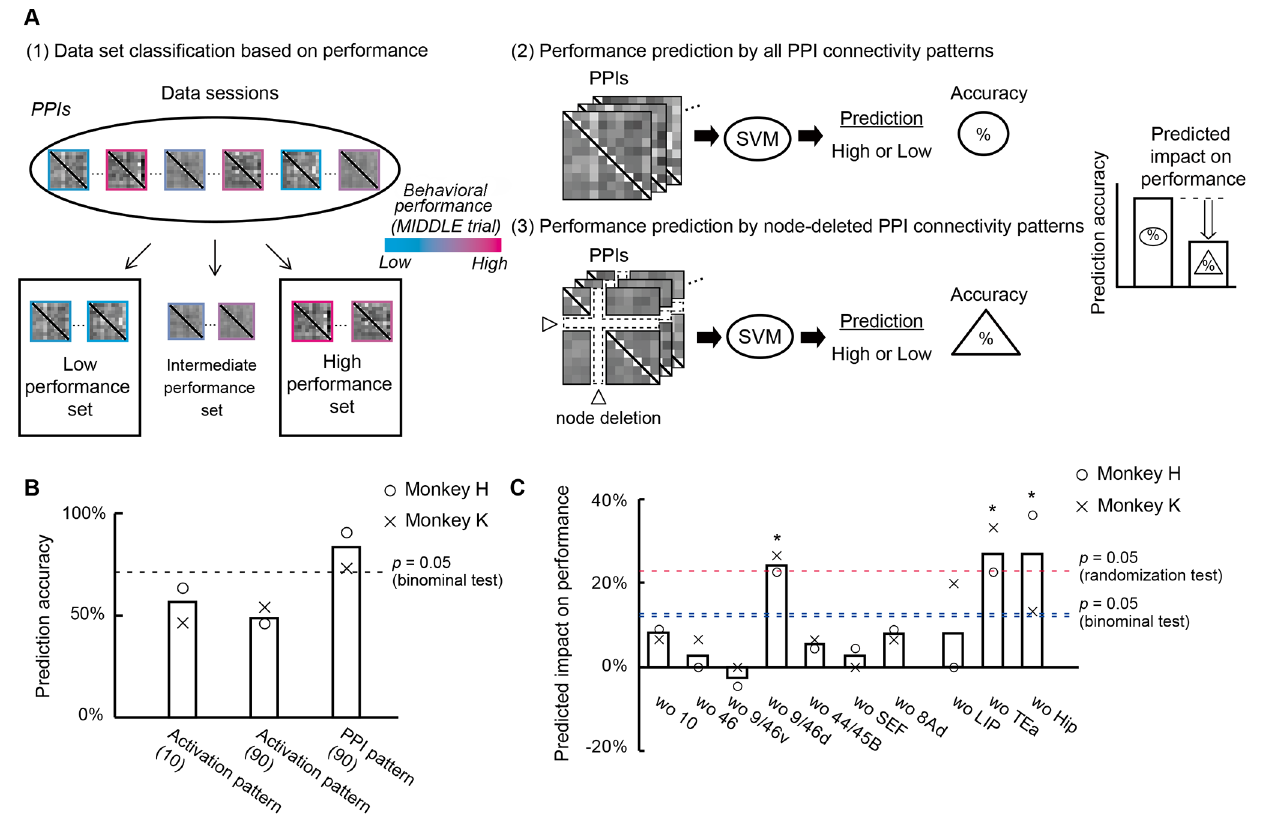
Fig 5. Prediction of behavioral performance and behavioral impairment after lesioning based on connectivity pattern. (A) Schematic of SVM-based MVPA prediction. (1) First, the whole data session set was divided into three classes based on behavioral performance in the MIDDLE trials (high, intermediate, and low performance sets). (2) Second, performance levels (high or low) in each session were predicted from the PPI connectivity pattern. (3) Finally, using node-deleted PPI connectivity patterns, SVM prediction was conducted. By comparing the prediction accuracies between (2) and (3), the predicted impact on performance after removal of a certain area was assessed. (B) Accuracy of behavioral performance prediction using activation patterns among the ten areas with ten features (left), activation patterns with 90 features (middle), and PPI connectivity patterns (right). The dashed line indicates accuracy significantly higher than chance ( p = 0.05, binominal test, for group). Each circle and cross represents data for monkey H and monkey K, respectively. The number of features is shown in the brackets. (C) Predicted impact on performance after removal of the indicated areas is plotted. The red dashed line indicates significant predicted impact on performance ( p = 0.05, randomization test, for group). * p < 0.05. The blue double dashed lines indicate prediction accuracy significantly higher than chance ( p = 0.05, binominal test, for group). Bars below the blue double dashed lines indicate prediction accuracies still significantly better than chance after removal of the